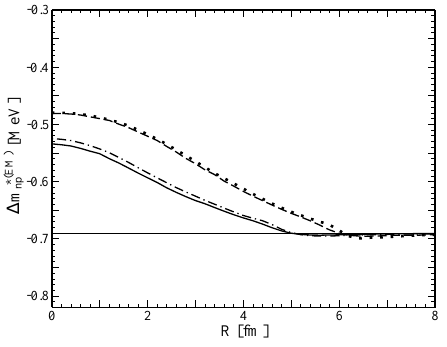
Fig. 4. The dependence of ∆ m ∗ (EM) np on the distance R between p the center of the skyrmion and the center of the nucleus. The notations and input are the same as in Fig. 2, with the excep- tion that the horizontal line marks the free space value ∆ m (EM) np = 0 . 69 MeV. Figure from Ref. [44]. − → 41